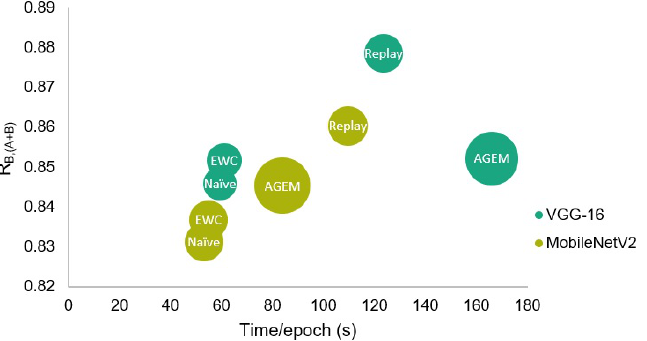
Figure 8. Comparison of the different incremental learning strategies in terms of global test accuracy, training time, and RAM. The circles’ diameter is proportional to the required